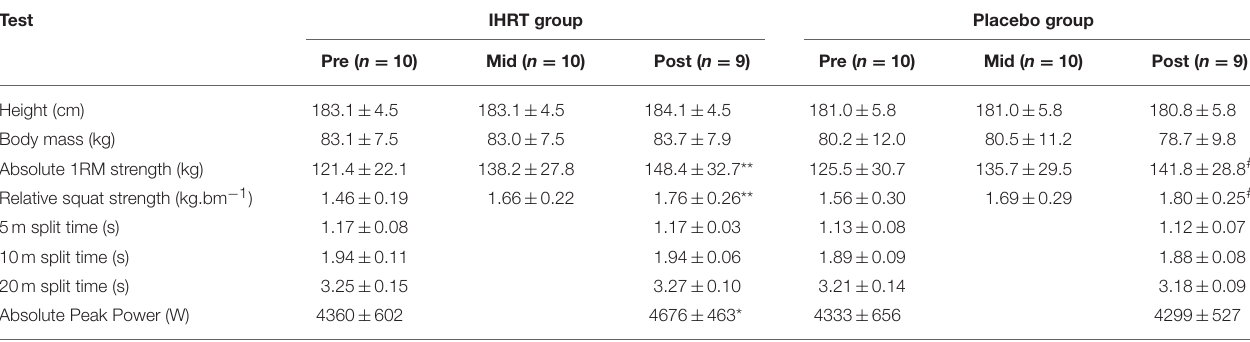
TABLE 2 | Testing results for all performance tests for both IHRT and Placebo groups.